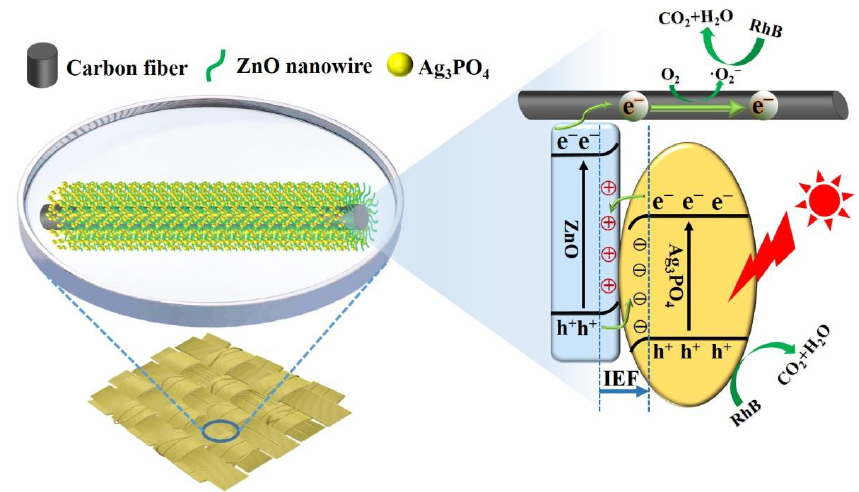
Figure 8. Schematic diagram for the improved charge separation of the CC/ZnO@Ag 3 PO 4 compo- site.